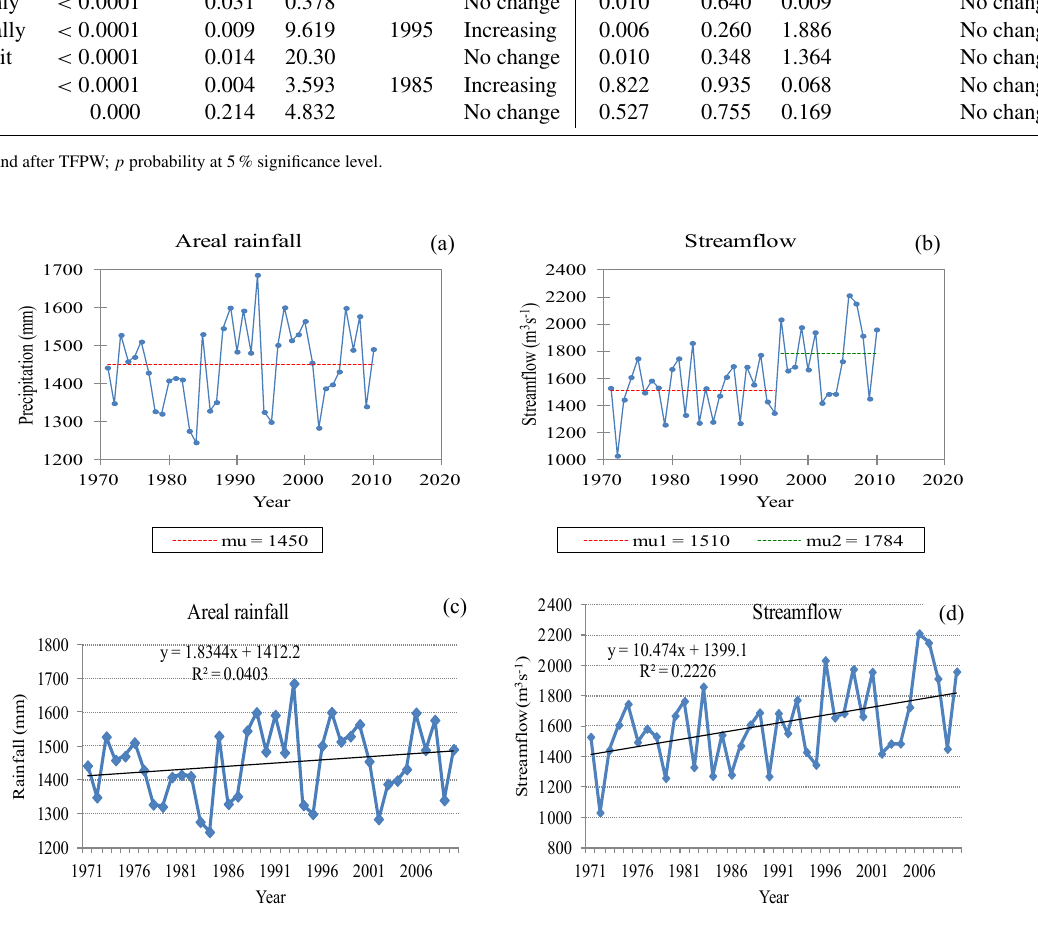
Figure 3. The Pettitt homogeneity test’s (a) annual rainfall, (b) annual flow of the UBNRB, (c) linear trend of mean annual rainfall, and (d) linear trend of mean annual streamflow, where mu is the mean annual precipitation (mm), mu1 is the mean annual precipitation before change (mm), and mu2 is the mean annual precipitation after change